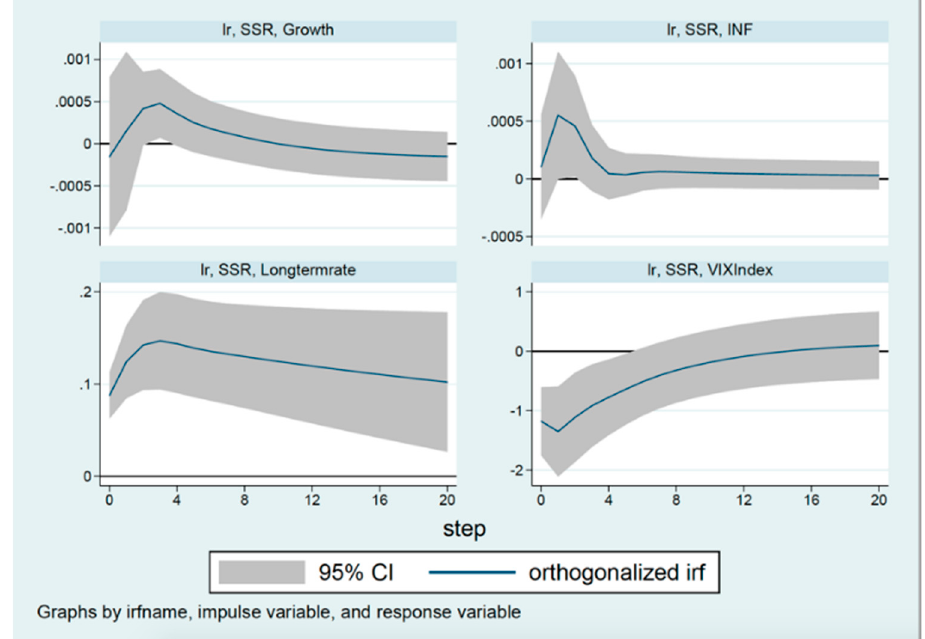
Figure 6. Impulses responses of US macroeconomic variables to monetary policy shocks.